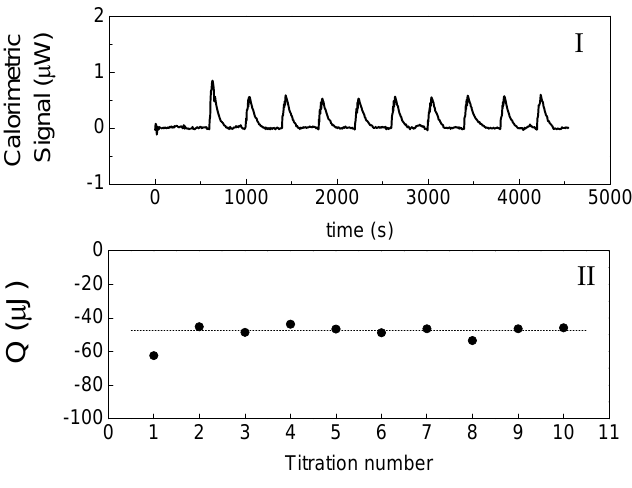
Figure 2. Titration of water with water at 30 ° C. Graph I shows the calorimetric signal as function of the time and graph II shows the heat involved in each titration. This heat is calculated by the integral of the calorimetric signal between the initial and final times for each peak. The volume titrated for each peak is 20 μ L and the volume cell is 1,300 μ